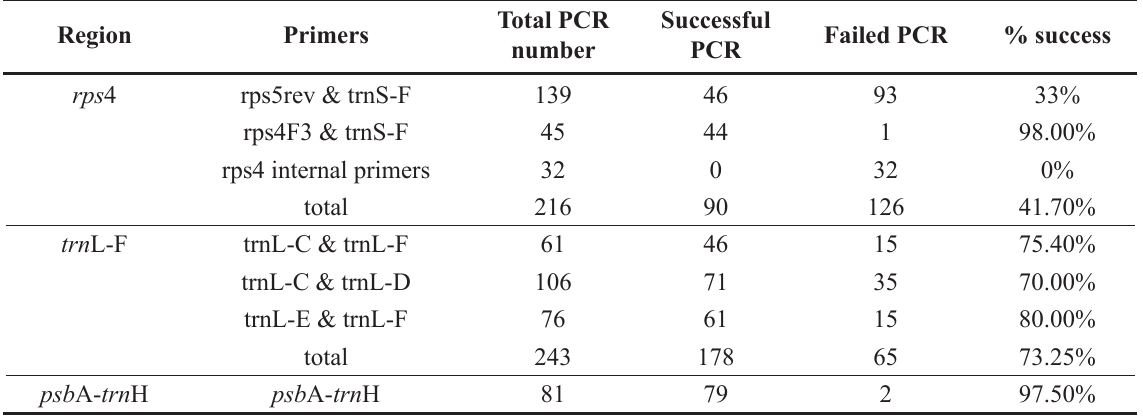
Table 5. Overview of PCR success depending on primer couples